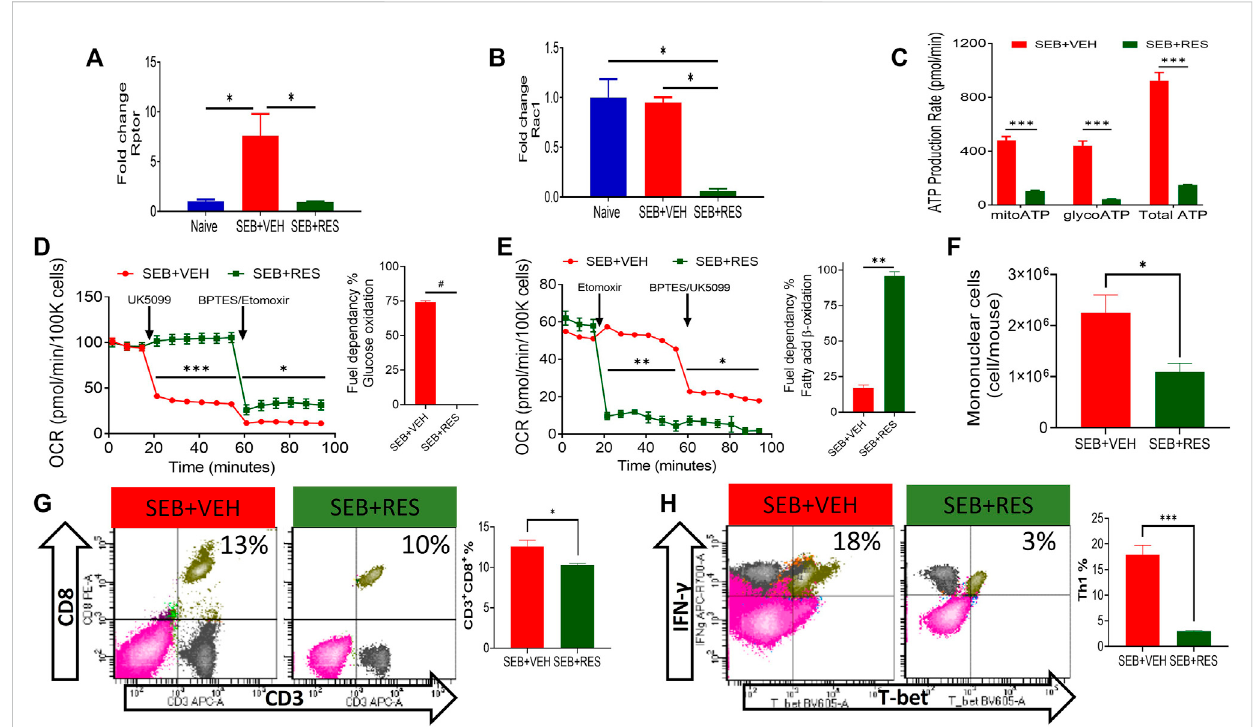
Upregulation of miR-100 by RES treatment leads to reprogramming of SEB-activated T cell mitochondrial function from fatty acid biosynthesis into fatty acid β -oxidation. Mice were treated with SEB + VEH or SEB + RES as mentioned in Figure 1 legend. Total RNA isolated from lung MNC was further analyzed. (A,B) . Real-time qPCR quanti fi cation of Rptor and Rac1 gene expression in the MNCs isolated from the lungs. (C) . Real-time kinetic data in live cells showing ATP production by mitochondria (mitoATP), glycolysis (glycoATP) and total ATP in puri fi ed T cells. (D,E) . Mitochondrial fuel